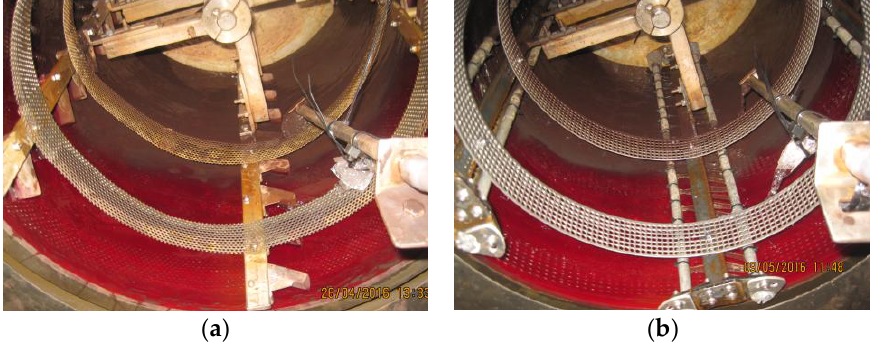
Figure 4. ( a ) Photograph of Mozley C-900 MGS with conventional scraping blades; ( b ) photograph of Mozley C-900 MGS with novel, low profile scraping blades.